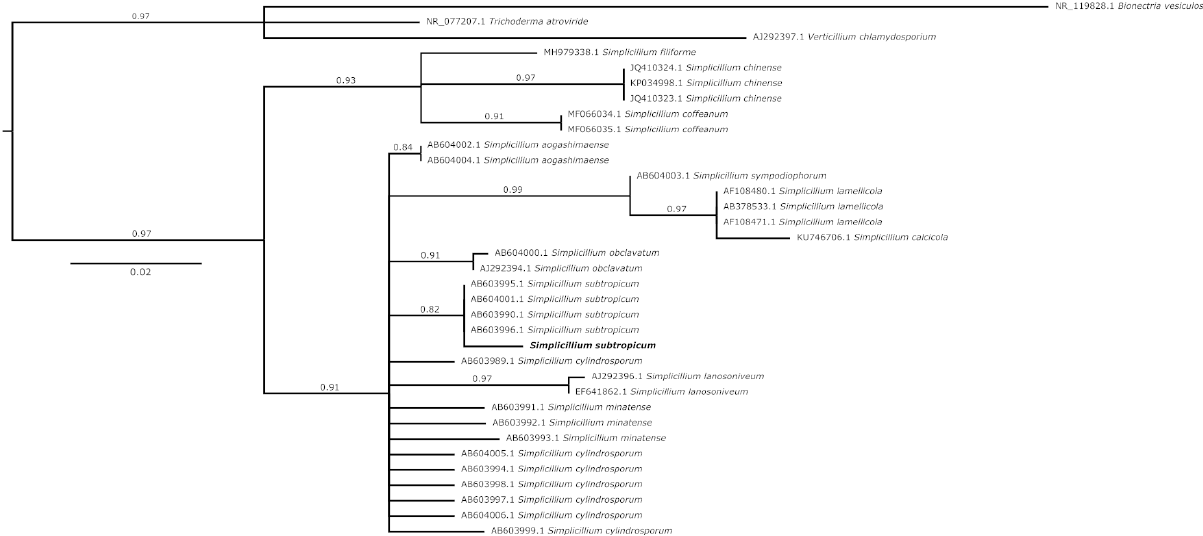
Figure 1 ‒ Simplicillium subtropicum species phylogenetic tree. A species tree based on ITS sequences was constructed to establish the relationships between the Simplicillium species with available ITS sequences and strain IBCB 79. Bionectria vesiculosa , Trichoderma atroviride , and Verticillium chlamydosporium entries were employed as outgroup and the tree was rooted in these species. Phylogenetic analysis was performed using Maximum-likelihood. Branch support values (aLRT SH-like supports) are associated with nodes. Polytomies were included when branch support values were lower than 0.80.